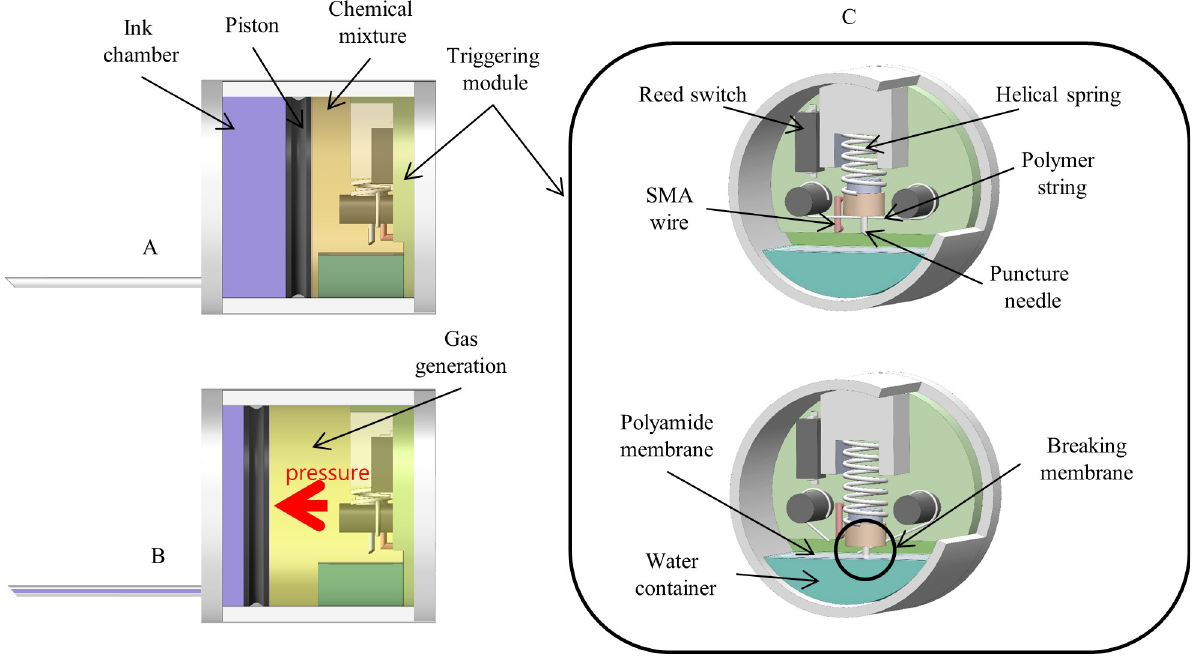
Fig 4. Tattooing module in details. (A) Tattooing module with components at the initial state. (B) Tattooing module after triggering the chemical reaction. (C) The chemical-reaction triggering module using reed switch.